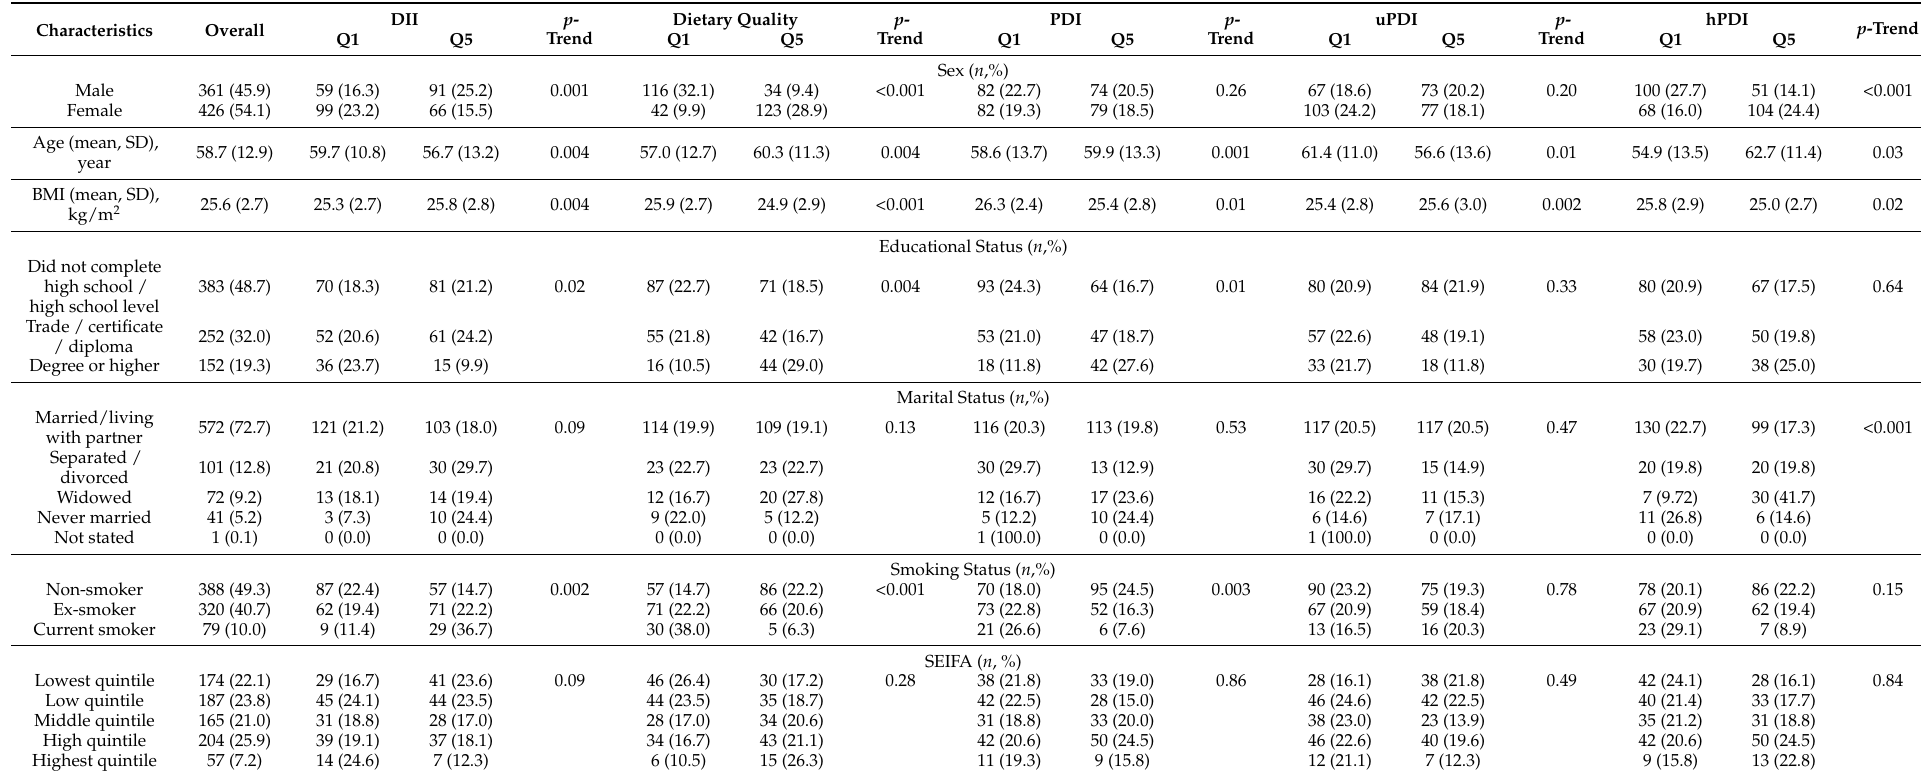
Table 1. Baseline characteristics of participants based on the highest and lowest quintiles of DII, diet quality, PDI, uPDI and